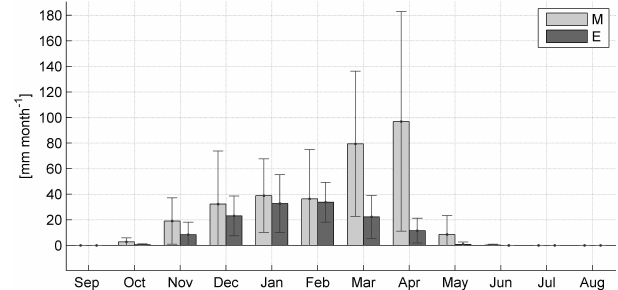
Figure 9. Mean monthly snowmelt ( M ) and evaposublimation ( E ) rates in mmmonth − 1 during the year at Refugio Poqueira site for the study period 2008–2015. Whiskers represent standard deviation from the mean.